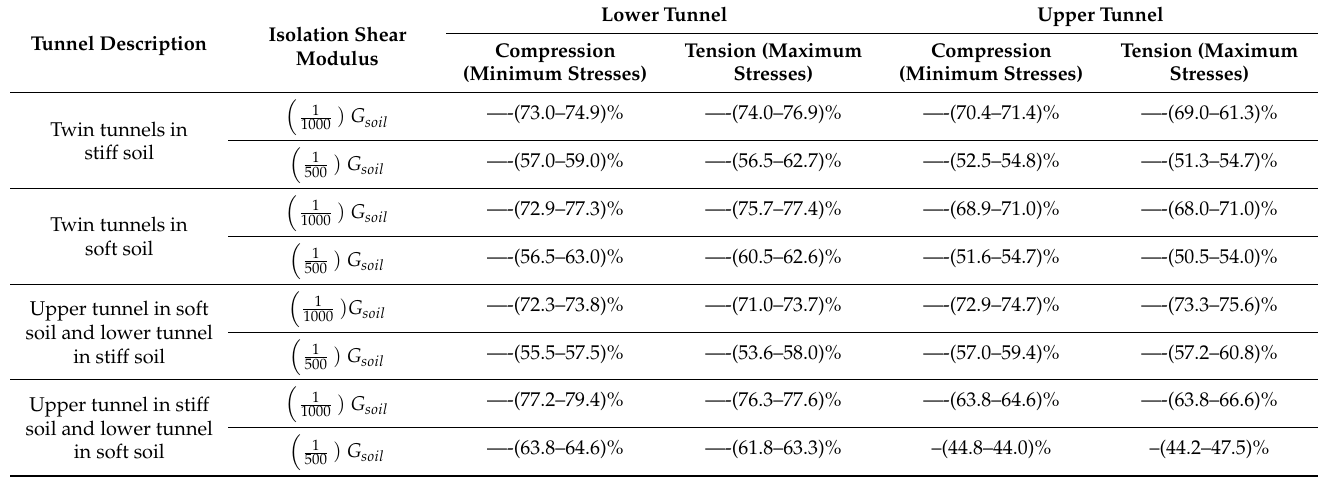
Table 6. Effect of using isolation instead of traditional grout.